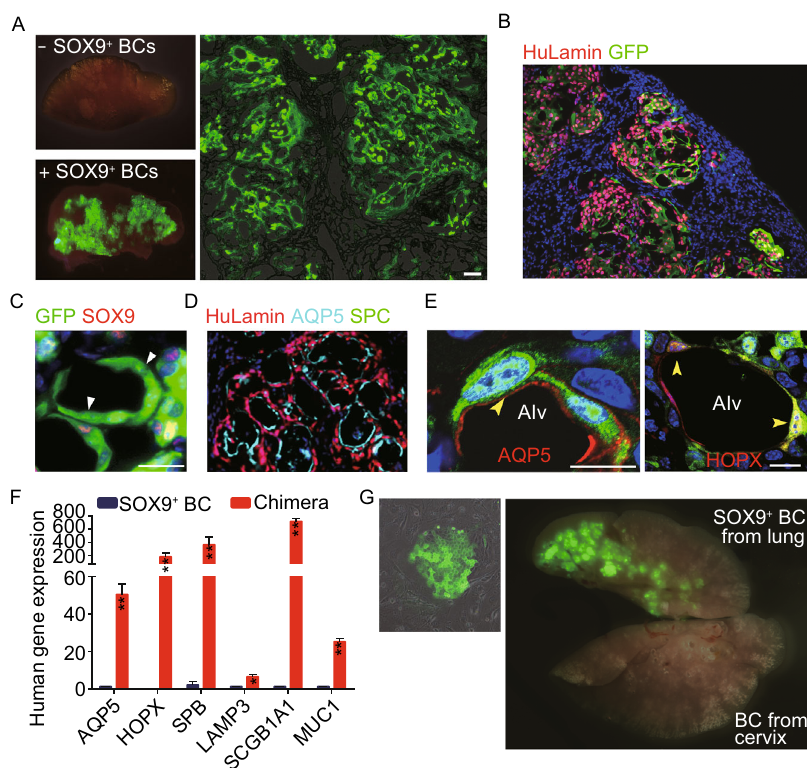
Figure 3. Transplantated SOX9 + BCs regenerate functional human lung in vivo . (A) Left, direct fl uorescence image under stereomicroscope showing NOD-SCID mouse lung without (upper panel) or with (lower panel) GFP-labeled SOX9 + BC transplantation. Right, cryo-section and direct fl uorescence imaging of transplanted GFP-labeled SOX9 + BCs in lung parenchyma. Scale bar, 100 μ m. (B) Immuno fl uorescence imaging of transplanted GFP-labeled SOX9 + BCs in lung parenchyma with human speci fi c Lamin A+C marker costaining. (C) Fully differentiated GFP + cells lost SOX9 marker expression (arrowhead indicated). Scale bar, 10 μ m. (D) Confocal image with human speci fi c Lamin A+C immunostaining (HuLamin) showing regenerated type I (AQP5 + ) alveolar cells. No type II (SPC + ) cells were observed. (E) Confocal image showing regenerated AEC1 (AQP5 + and HOPX + ). AQP5 as a membrane-bound protein distributes on surface of GFP + cells. Arrowheads indicated the overlay of HOPX with GFP signal in nucleus. Scale bar, 20 μ m. (F) qPCR with human speci fi c primers showing alveolar and bronchiolar epithelium marker gene expression in SOX9 + BC transplanted chimeric lung (AEC1: AQP5 and HOPX; AEC2: SPB and LAMP3; bronchiolar cells: SCGB1A1 and MUC1). Biological replicates, n = 3. Error bars, S.E.M. (G) Left, clonogenic BCs isolated from human cervix epithelium obtained by biopsy. Right, transplantation of equal numbers of BCs from lung and cervix indicated different incorporation ef fi